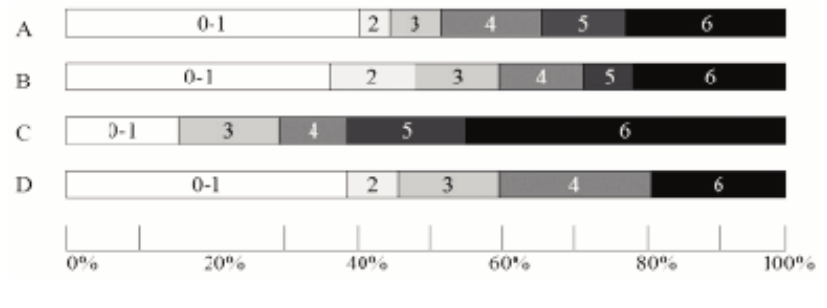
Figure 1. Stroke outcome at 3 months in patients treated with and without intravenous thrombolysis, classified by modified Rankin Scale (mRS). (A) Patients aged over 70 years without intravenous thrombolytic treatment. (B) Patients aged over 70 years with throm- bolytic treatment. (C) Patients aged over 80 years without intravenous thrombolytic treat- ment. (D) Patients aged over 80 years with thrombolytic